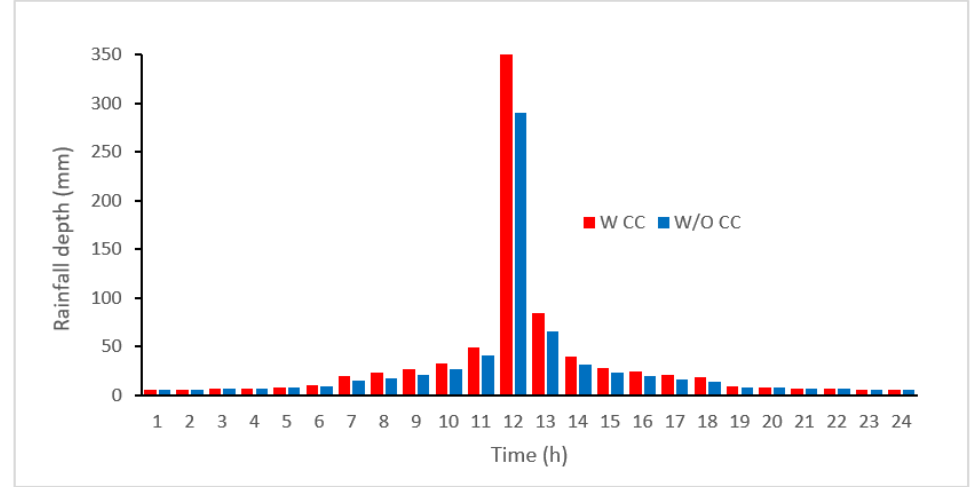
Figure 6. Precipitation hyetograph for PMP with CC (W CC) and without CC (W/O CC). HEC-HMS calculated the flood flow hydrographs for the Cachul watershed, showing values of 2819.3 m 3 /s and 2253.5 m 3 /s using the PMP with and without CC, respectively, which represents a difference of around 25% (Figure 7). The estimated design flows for PMP considering CC will cause over-storage in the Sube y Baja dam reservoir, making it necessary to verify the design capacity of the original spillway through a hydraulic anal- ysis.